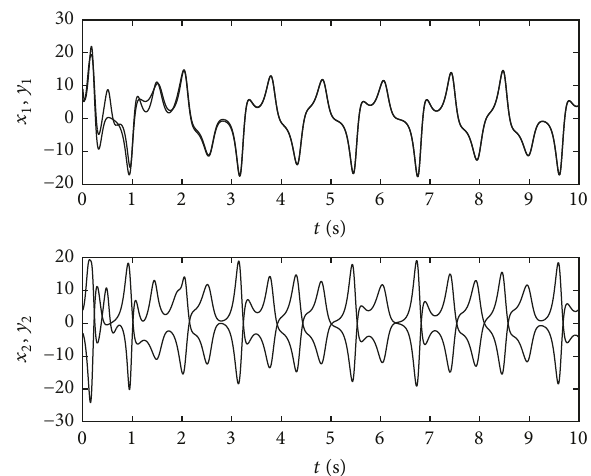
Figure 3: Complete synchronization and antisynchronization are realized for the Chen system.